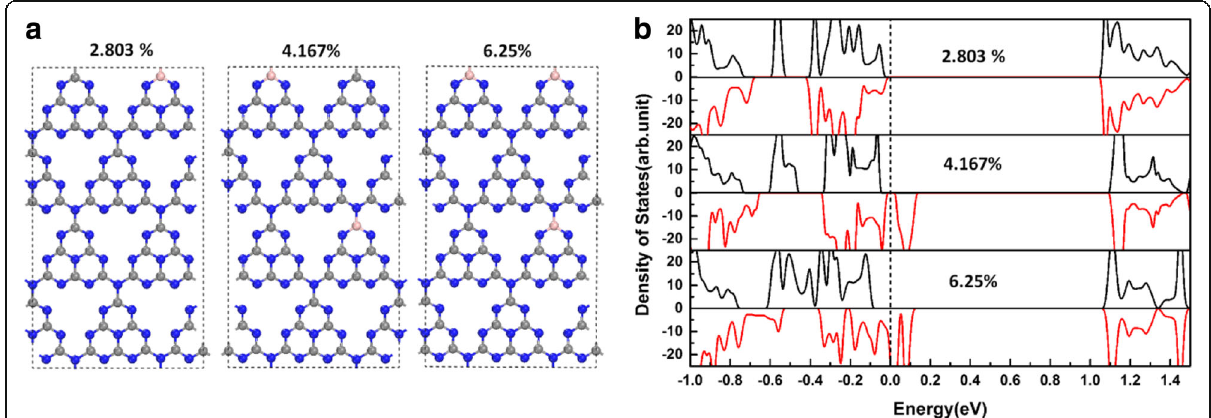
Fig. 4 a Schematic representations of the tetragonal 112-atomic supercell used to simulate different doping concentrations of B C1 @gh-C 3 N 4. b The spin-dependent total density of states of B C1 @gh-C 3 N 4 with different doping concentrations. The energy at the Fermi level is set to zero